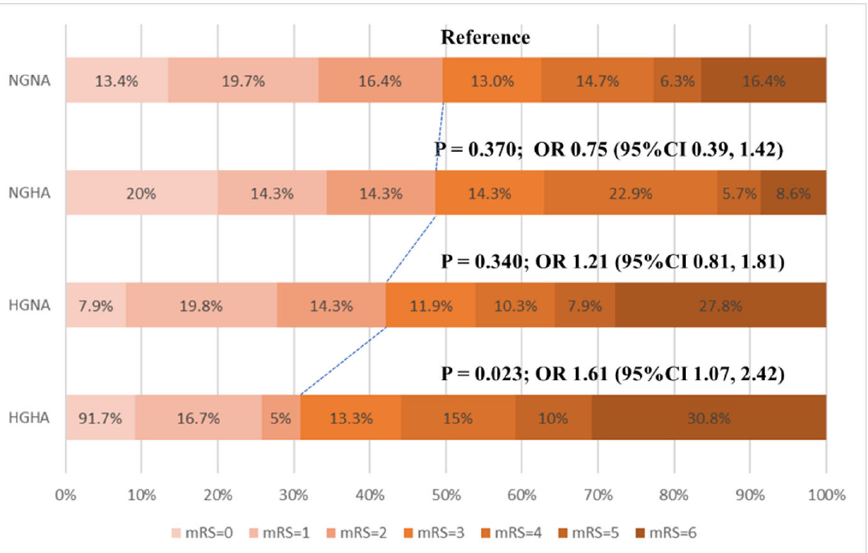
Figure 2. Correlation of different groups and functional improvement (multivariate ordinal logistic regression) according to the distribution of the mRS score at 3 months. Scores range from 0 to 6, with 0 indicating no symptoms, 1 no clinically significant disability, 2 slight disability (patient is able to look after own affairs without assistance but has one or more symptoms), 3 moderate disability (patient requires some help but is able to walk unassisted), 4 moderately severe disability (patient is unable to attend to bodily needs without assistance and is unable to walk unassisted), 5 severe disability (patient requires constant nursing care and attention), and 6 death. NGNA, normal glucose and normal HbA1c; NGHA, normal glucose and high HbA1c; HGNA, high glucose and normal HbA1c; HGHA, normal glucose and high HbA1c; mRS, modified Rankin Scale. The relationship between SHR and mRS score was also analyzed. After dividing the SHR into four equal quartiles, the other three quartiles were statistically associated with 3 ‐ month unfavorable functional outcomes compared with the lowest quartile (OR, 1.95; 95%CI, 1.06–3.57; p = 0.037 and OR, 2.19; 95%CI, 1.19–4.04; p = 0.014 and OR, 2.14; 95%CI,